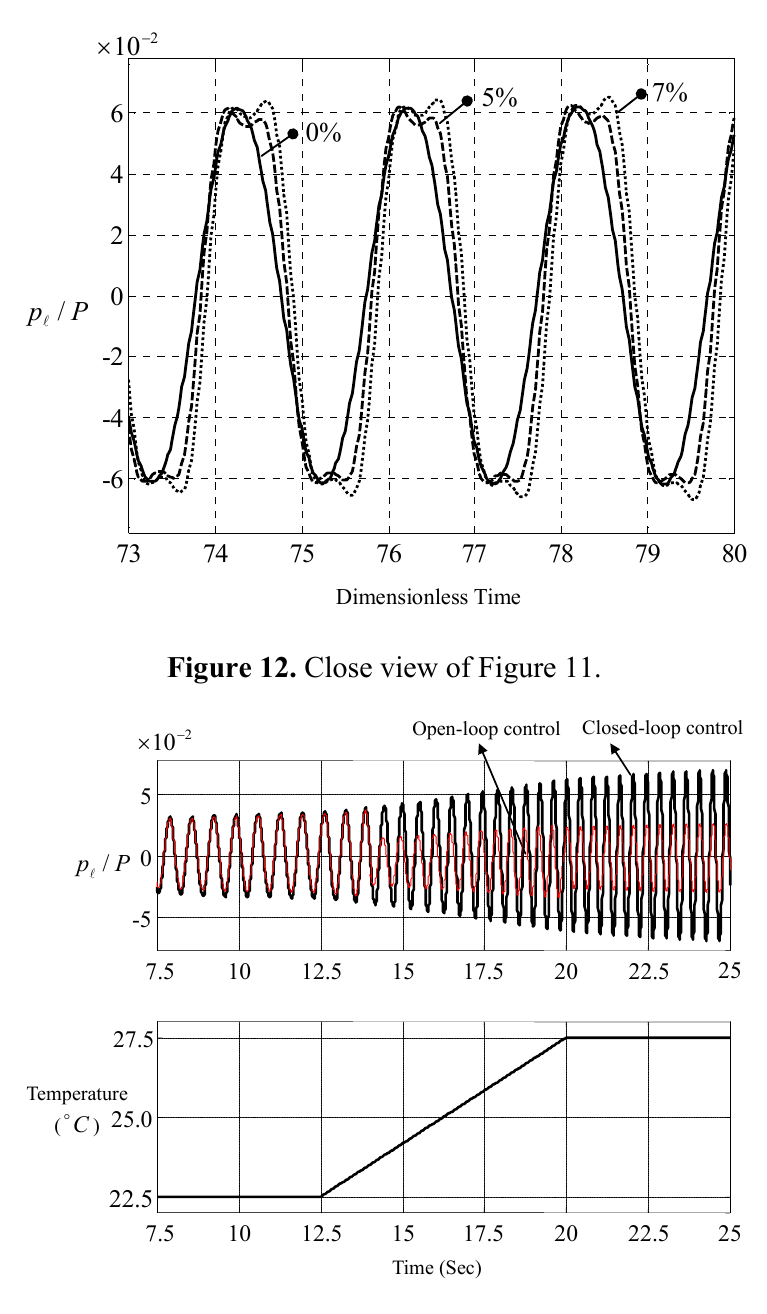
Figure 13. Measured temporal responses under time-variant